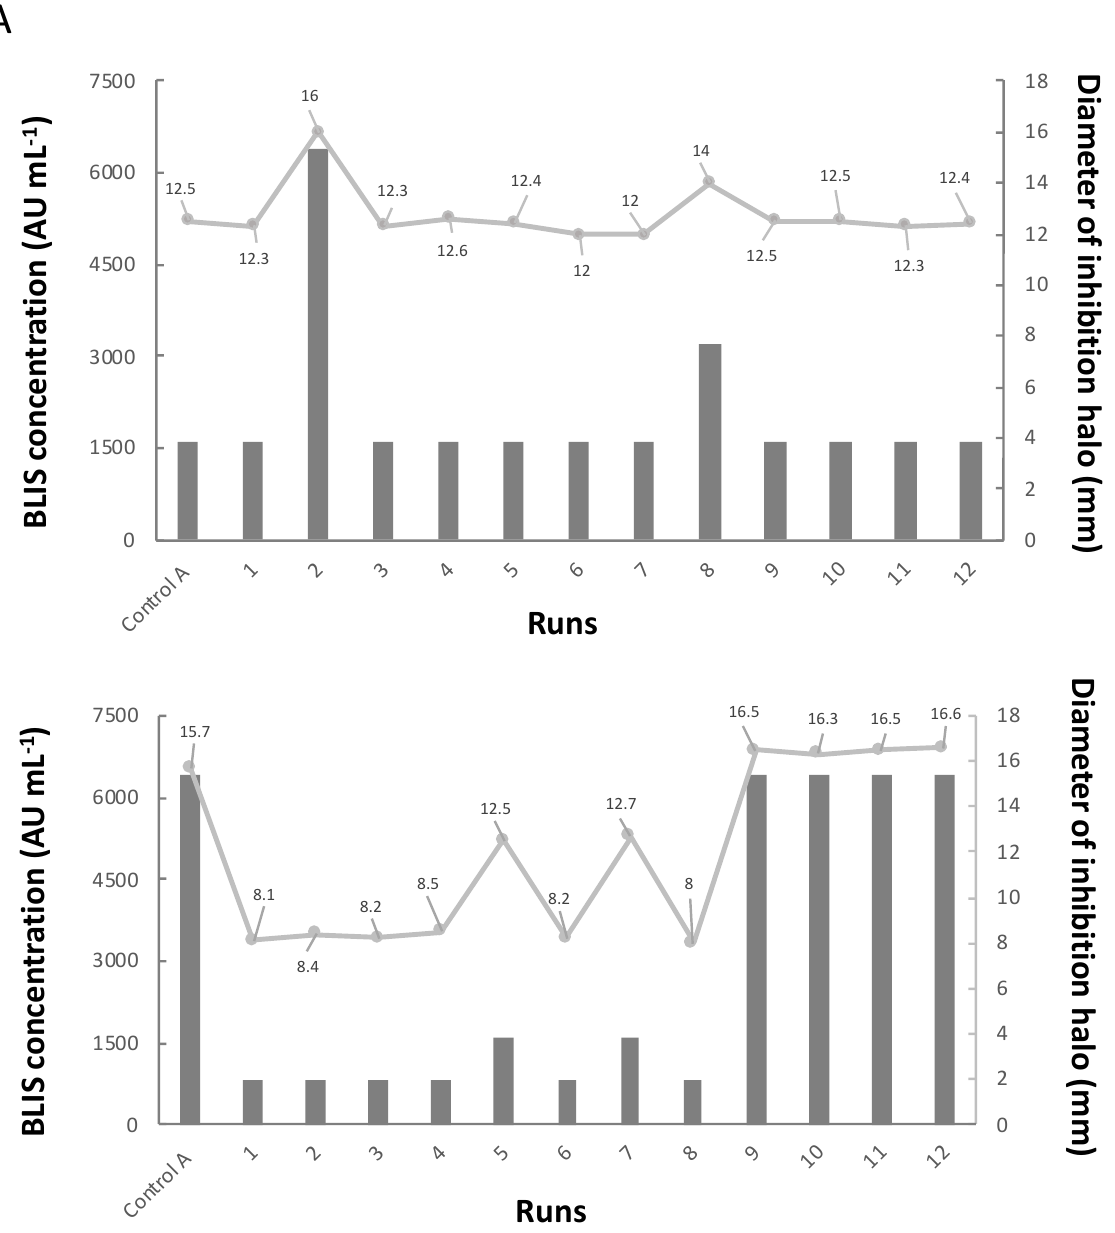
Figure 4. BLIS concentration expressed by AU mL − 1 ( (cid:4) ) and diameter of inhibition halo expressed by millimeter (mm) ( (cid:4) ) of P. pentosaceus ATCC 43200 BLIS against E. coli ATCC 25922 ( A ) and E. faecium 101 ( B ) selected as Gram-negative and Gram-positive indicator strains.